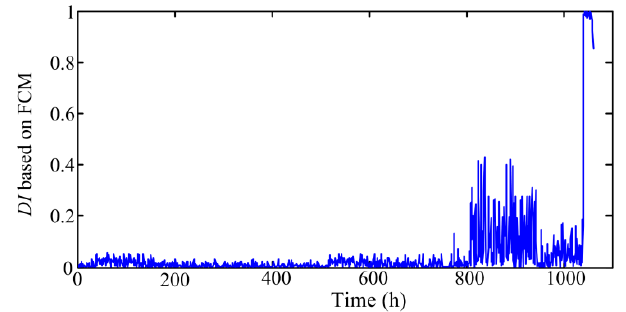
Figure 10. The obtained DI based on different time-domain statistical indicators; ( a ) RMS ( b ) WI. Figure 11. The DI obtained from FCM method.